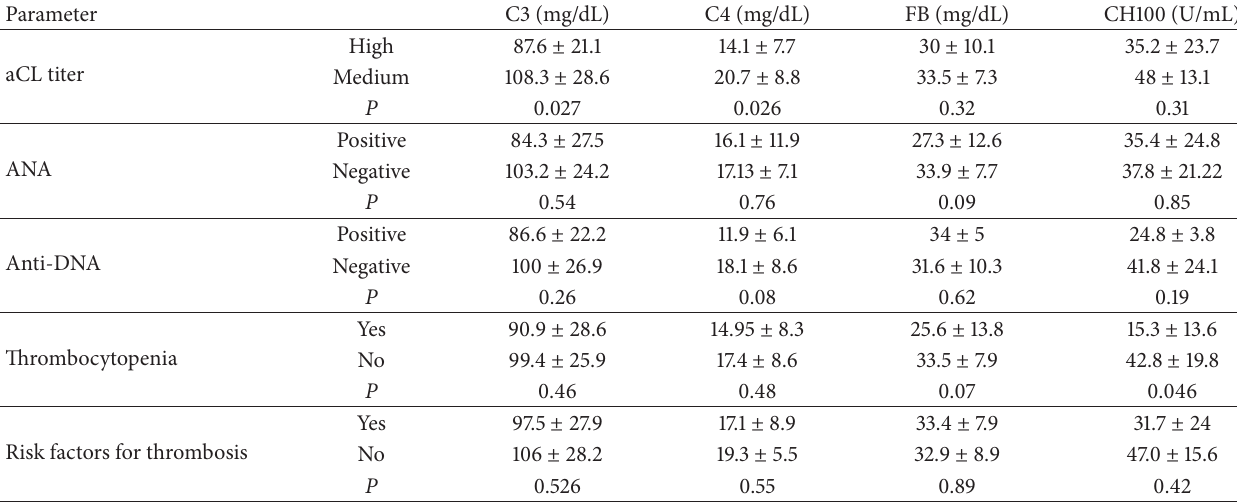
Table 3: Serum concentration and functional activity ofcomplement proteinsin thromboticAPS patients with specificlaboratory and clinical abnormalities.